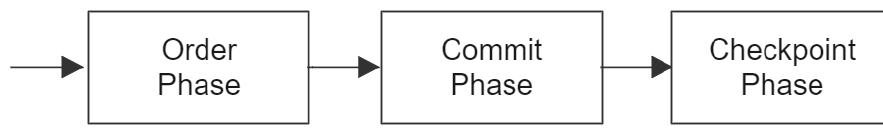
Figure 4. Order-then-commit transaction processing